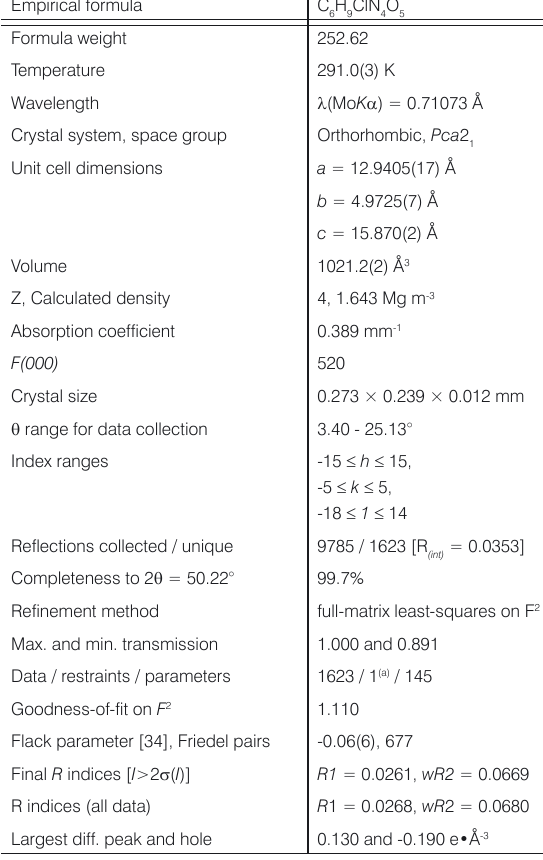
Table 1. Crystal data and structure refinement details for title